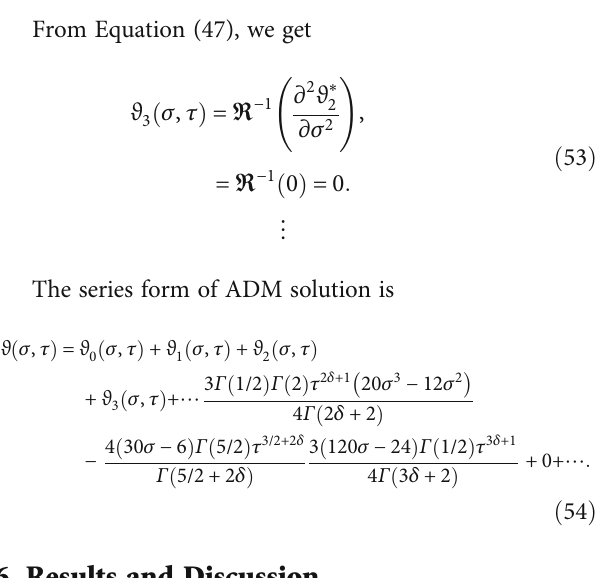
Figure 2: 2D plots of the exact and approximate solution for δ = 1 of Example